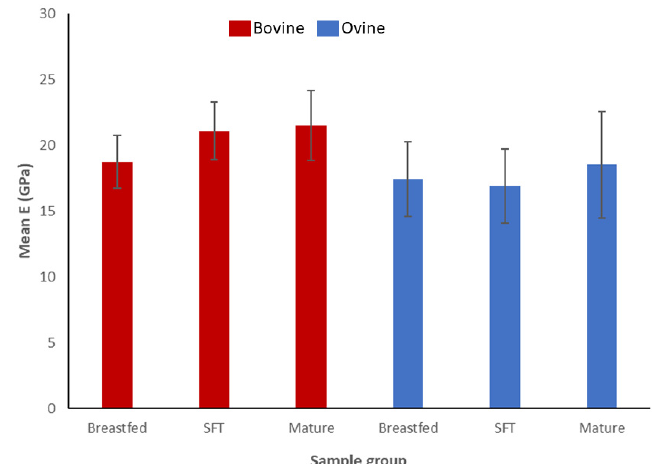
Figure 5. The bar chart represents the mean value of elastic modulus (E) with the respective stand- ard deviations of the analyzed samples. Bovine specimens are shown with red bars, whereas ovine specimens are colored